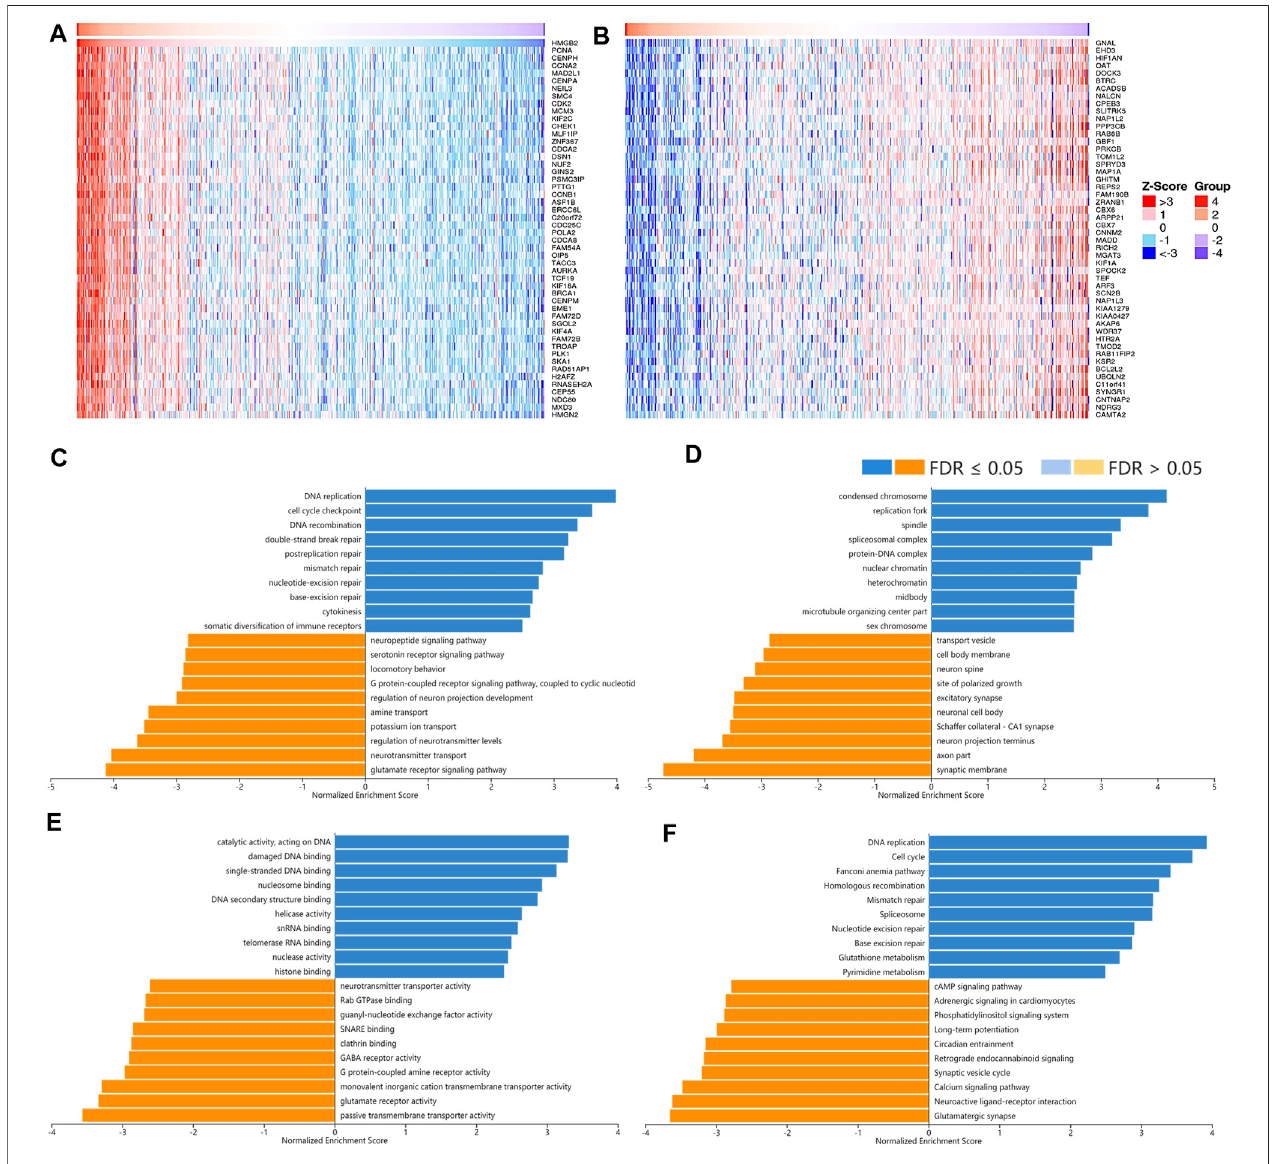
FIGURE 8 | The correlated genes of High Mobility Group Box 2 (HMGB2) in LGG and GSEA results. The top 50 genes signi fi cantly (A) positively and (B) negatively correlated with HMGB2 in LGG (LinkedOmics). The top 20 signi fi cantly enriched (C) GO-BP, (D) GO-CC, (E) GO-MF, and (F) KEGG pathway terms of HMGB2 correlated genes based on GSEA. A bar represents a normalized enrichment score for a term, which in orange or blue represents negatively or positively enriched respectively.